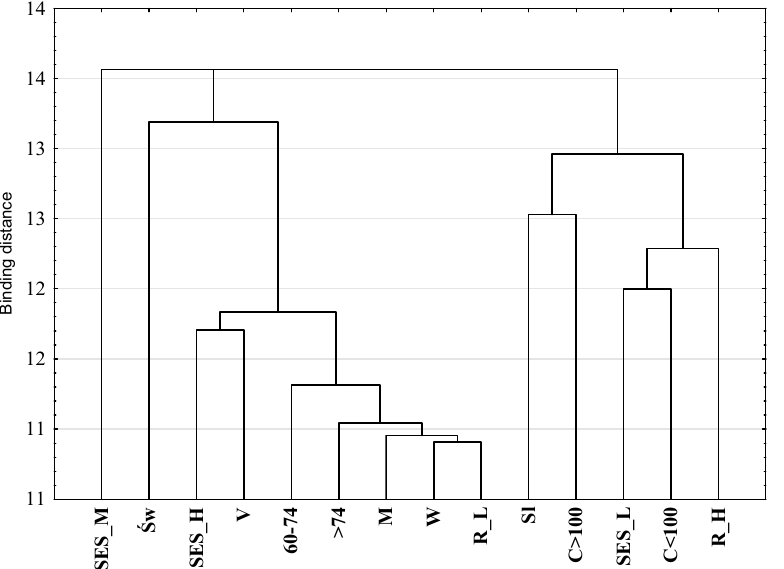
Figure 2. The hierarchical classification of variables describing nutritional risk, selected demo- graphic features and declared socioeconomic status. R_H—high nutritional risk; R_L—low nutritional risk; W—woman; M—man; 60–74—age in years; >75—age 75 and over; C < 100—city with up to 100,000 inhabitants; V—village; C > 100—city with over 100,000 inhabitants; Ś w— Ś wi ę tokrzyskie Voivodeship; Sl—Dolno ś l ą skie Voivodeship; SES_L—low socioeconomic status; SES_M—medium socioeconomic status; SES_H—high socioeconomic status.